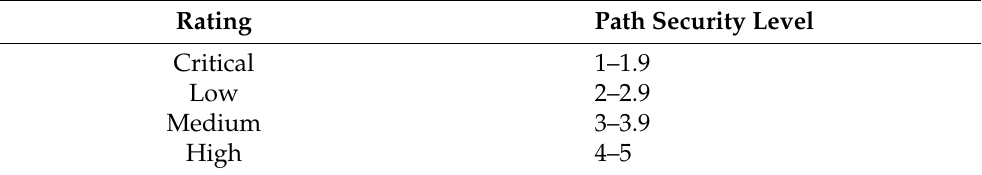
Table 2. Security level rating